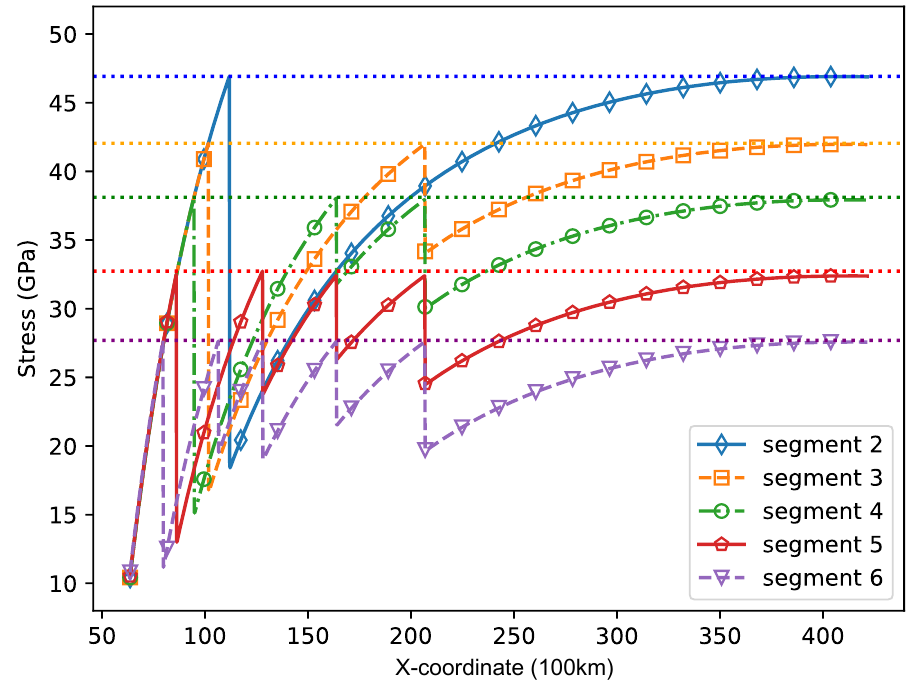
Figure 11. Stress distribution diagram of segmented space elevator system with 2 to 6